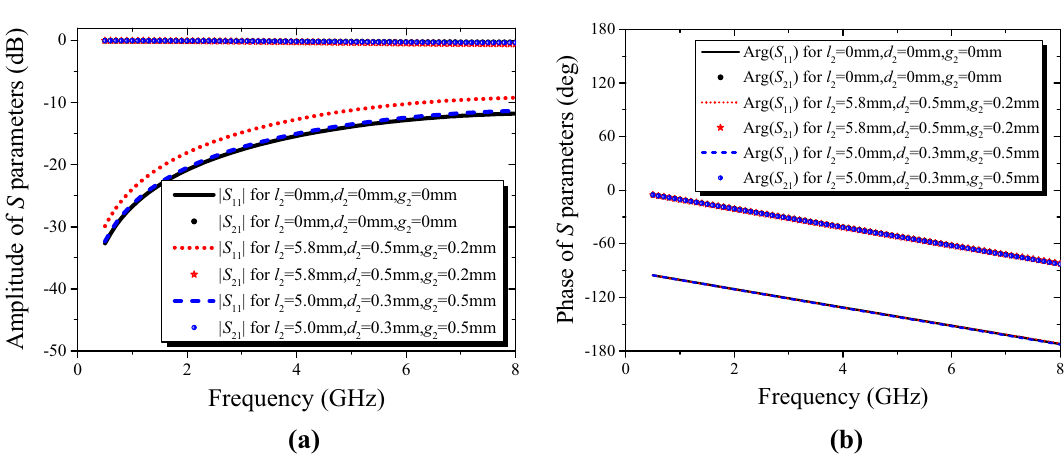
Figure 3. Variations of S parameters for the proposed anisotropic cells with different bottom dimensions (